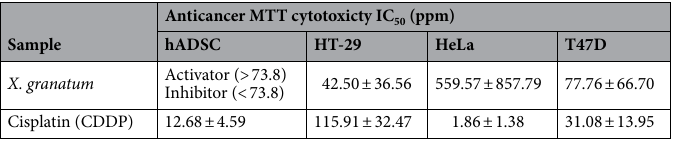
Table 4. Anticancer IC 50 for extract and CDDP against